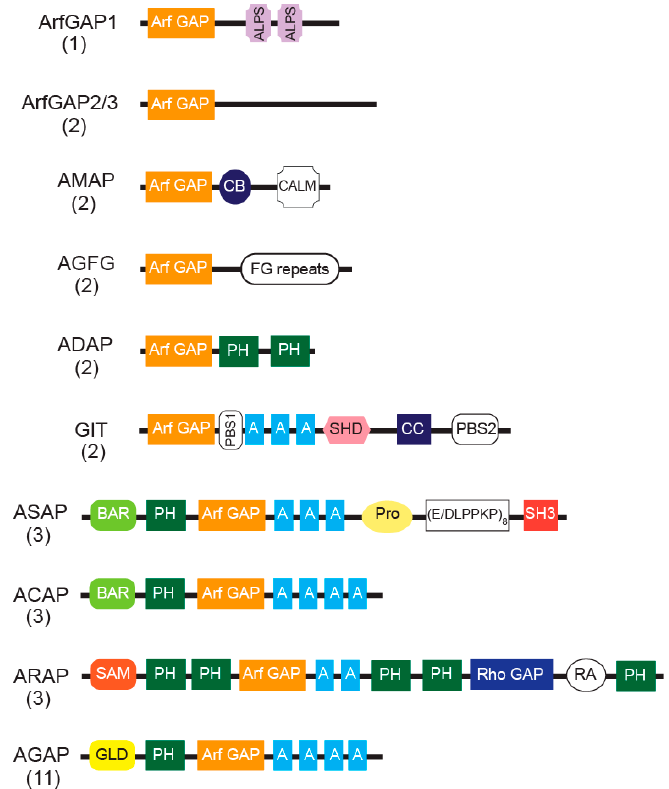
Figure 1. The domain structures of Arf GAPs. Representative domain organizations of each human Arf GAP group are depicted but not to scale. The number in parentheses below the name of the subfamily indicates the number of members in each Arf GAP subfamily. Arf GAP, Arf GTPase ‐